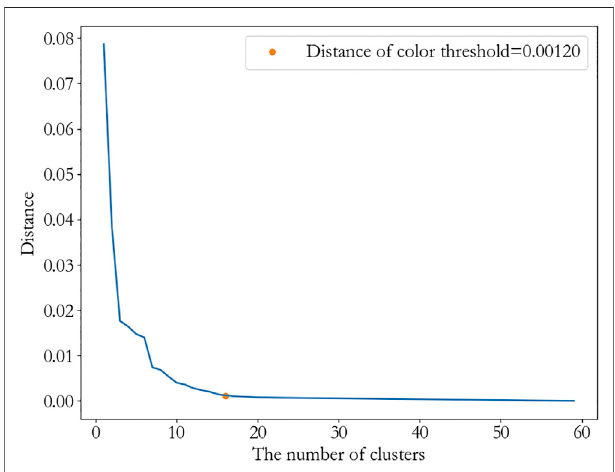
FIGURE 5 | The color threshold corresponding to the different numbers of clusters.